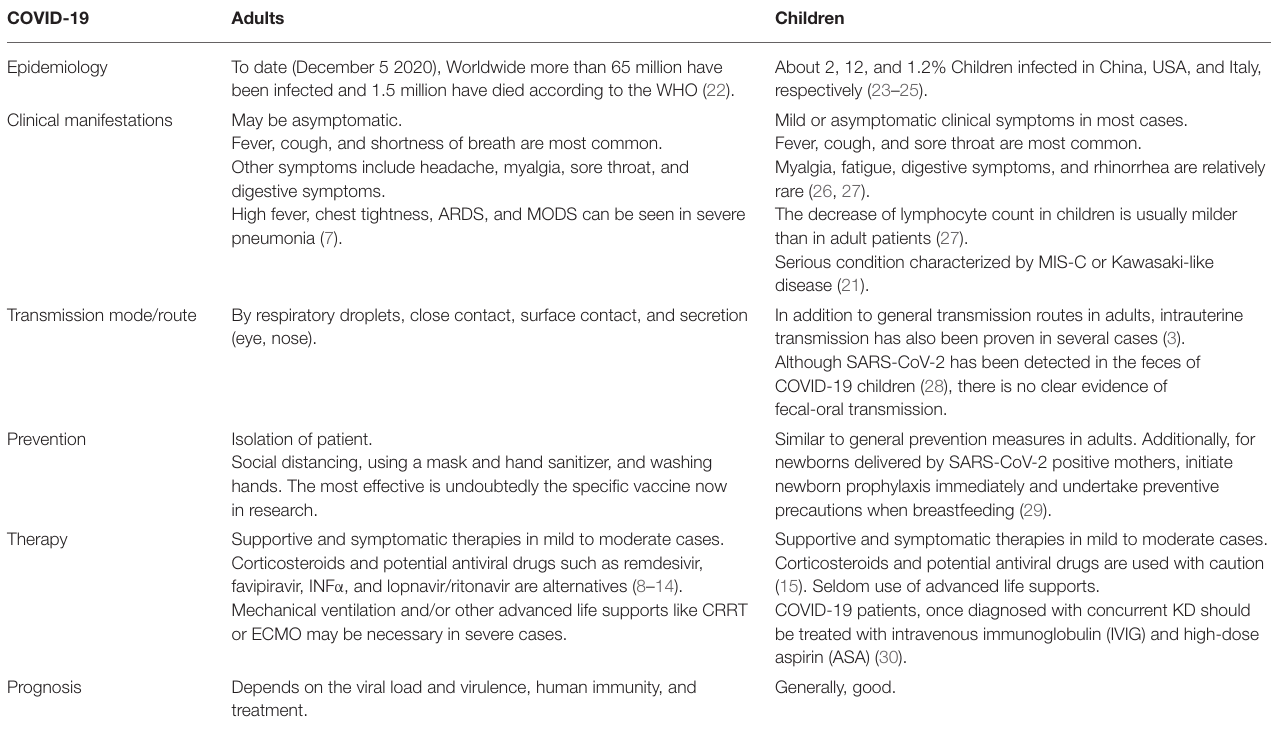
TABLE 1 | Comparable characteristics between COVID-19/ SARS-CoV-2 infected adults and children.